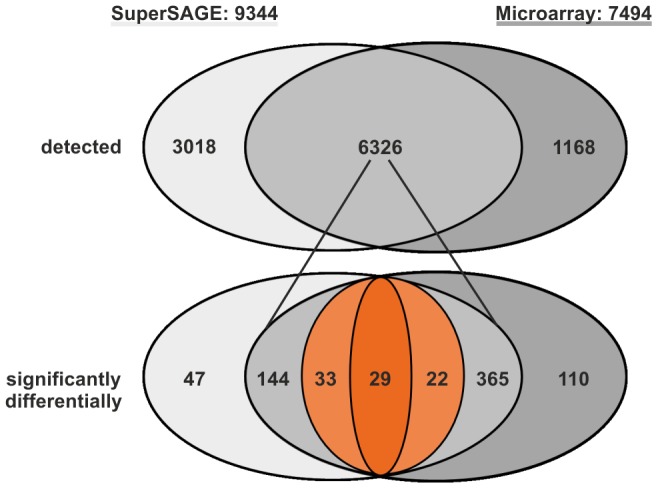
Venn diagram of SuperSAGE and microarray data analyses.For final analyses we selected 9344 and 7494 genes for which sense transcripts were detected by SuperSAGE and microarray, respectively. The upper diagram (detected) presents numbers of genes, whose transcripts were identified by either one (light grey, left: SuperSAGE, 3018; dark grey, right: Microarray, 1168) or both methods (intersection; grey, middle part, 6326). The lower diagram (significantly differentially) presents genes, whose transcripts were significantly differentially (Super SAGE, p<1−10; Microarray, q<0.01; log2ratios <−0.585 or >0.585) regulated between EM and UM according to at least one analysis (outside the intersection: light grey, left: SuperSAGE, 47; dark grey, right: microarray, 110; within the intersection: grey, left: 144 found as differentially transcribed according to SuperSAGE only; grey, right: 365 found as differentially transcribed according to microarray data analysis only; light orange, left, 33: found as significantly regulated by both analyses but differentially transcribed only according to SuperSAGE; light orange, right, 22: found as significantly regulated by both analyses but differentially transcribed according to microarray data analysis only). Finally, a number of 29 transcripts (dark orange, middle) were found representing genes being differentially transcribed according to the analyses of the data sets obtained by both methods.